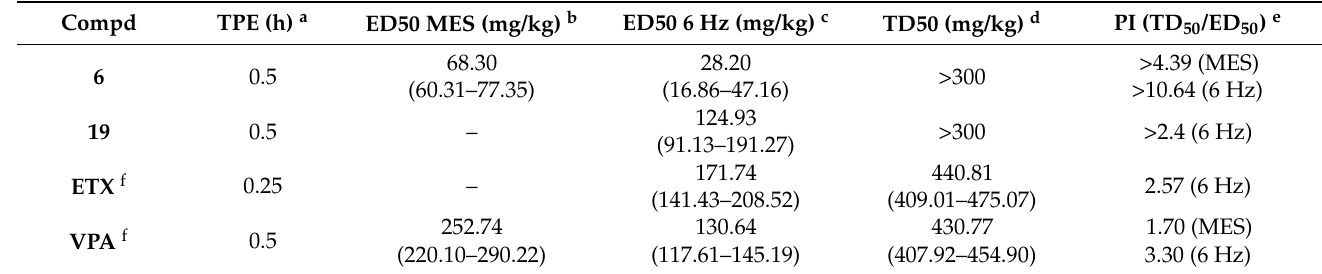
Table 3. Quantitative pharmacological parameters ED 50 , TD 50 , and PI values in mice